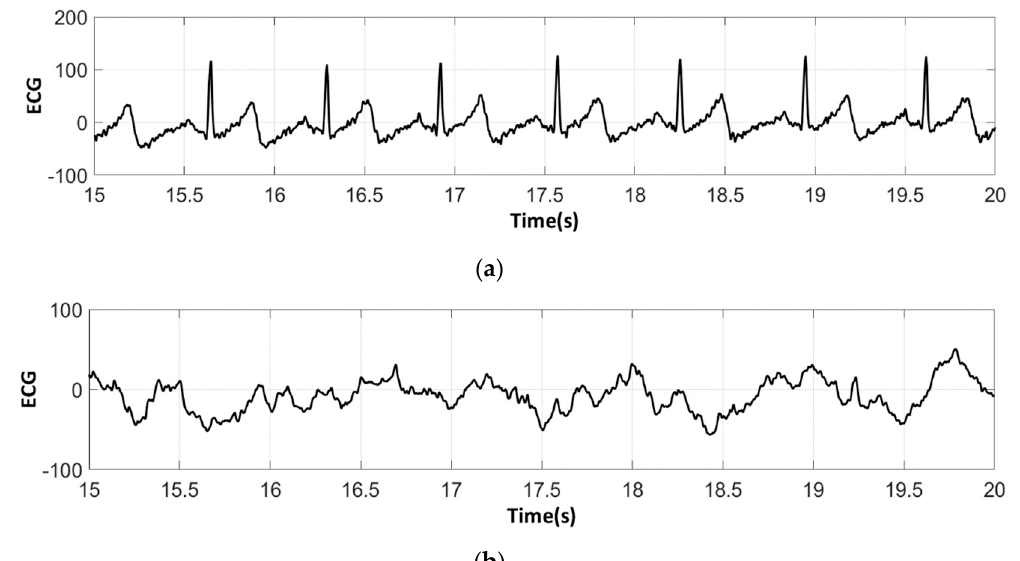
Figure 18. ECG signal obtained by cotton/Lycra electrodes with 11.9 wt.% PEDOT:PSS: ( a ) before washing; ( b ) after 50 washing cycles.